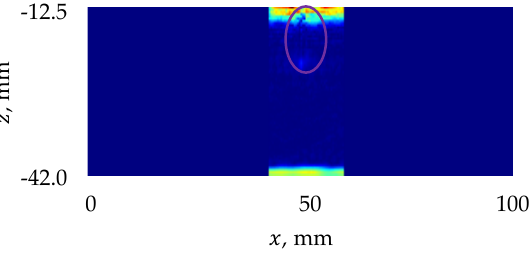
Figure 11. The DPS data set: the TFM image of the surface-breaking notch (circled) located 70 mm from the left edge, imaged from the notched side. Key as in Figure 7.